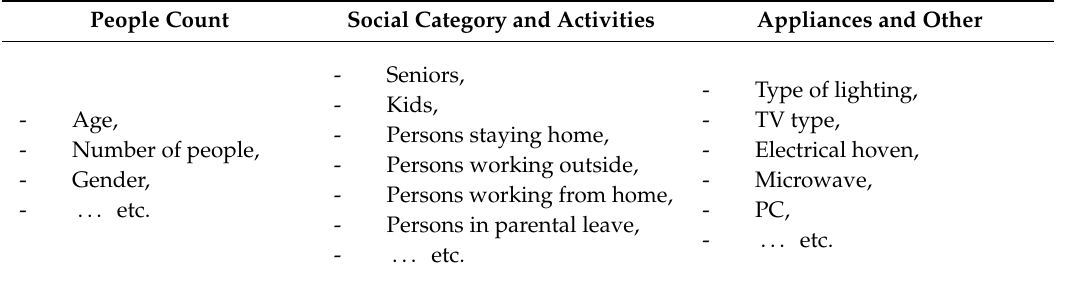
Table 1. Survey main